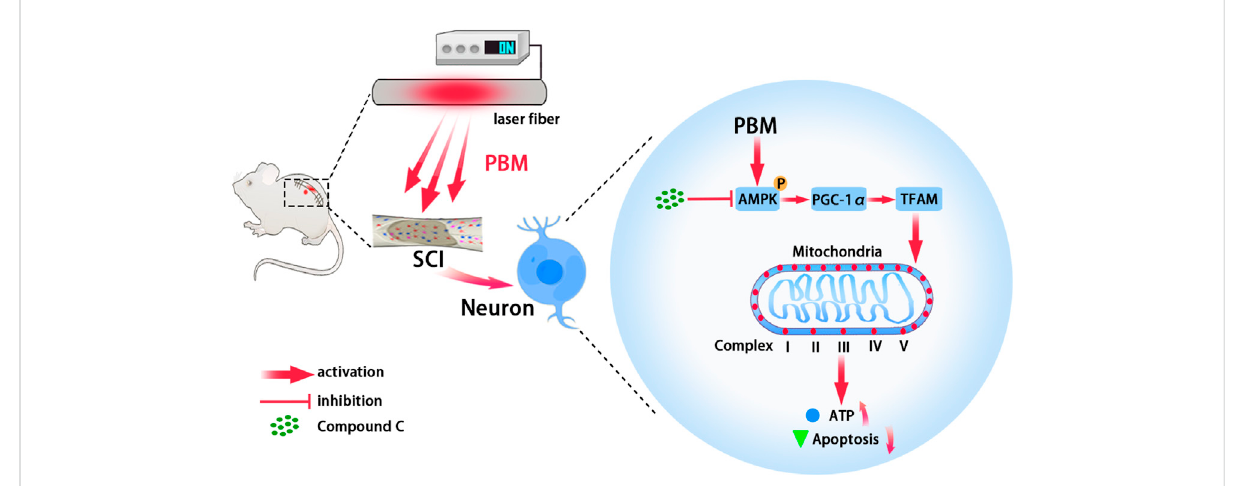
FIGURE 7 Graphic summary. Embedding fi ber mediated PBM restored the activity of mitochondrial respiratory chain complex by activating the AMPK/ PGC-1 α /TFAM pathway, thus increased ATP production and alleviated apoptosis of neurons after SCI. Picture was exported by